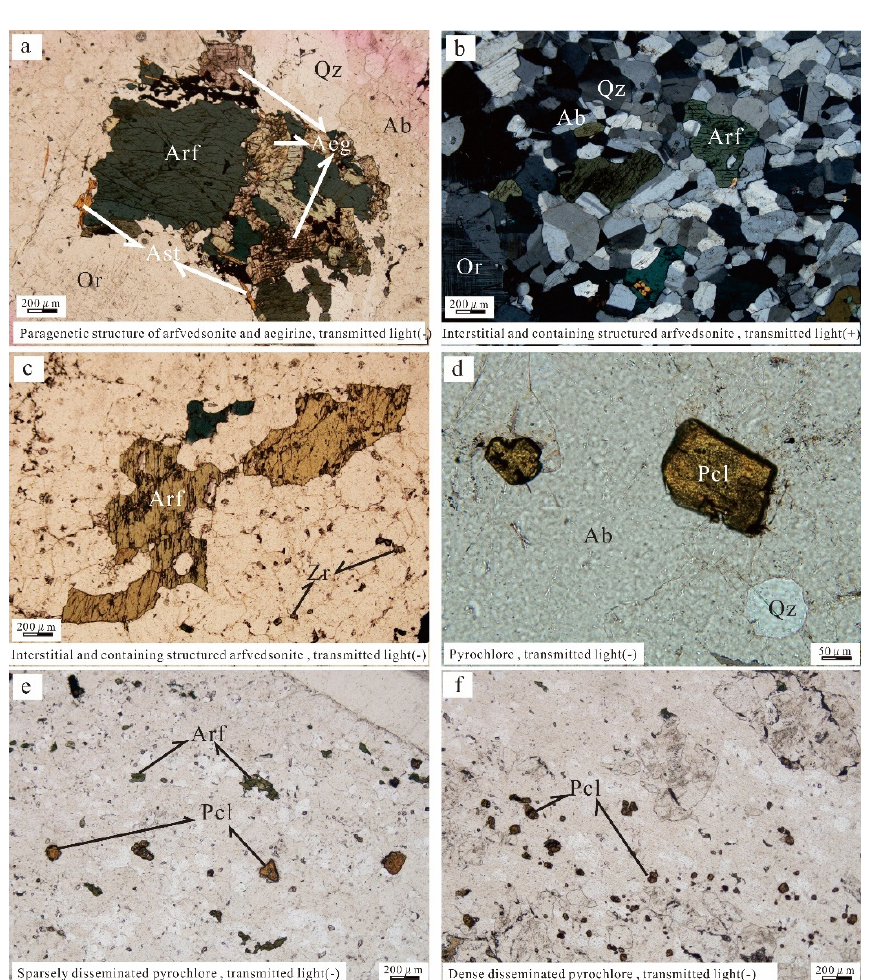
Figure 4. Microphotographs showing the textures of Boziguoer alkaline granite (( a , d ) = alkalic granite facies, ( b , e ) = syenite facies I, ( c , f ) = syenite facies II). Arf = arfvedsonite, Aeg = aegirine, Ast = astrophyllite, Qz = quartz, Or = orthoclase, Ab = albite, Pcl = pyrochlore supergroup minerals. Accessory minerals mainly comprise the pyrochlore supergroup minerals, zircon, astrophyllite, thorite, monazite, bastnasite, xenotime and fluorite. Most form either granular